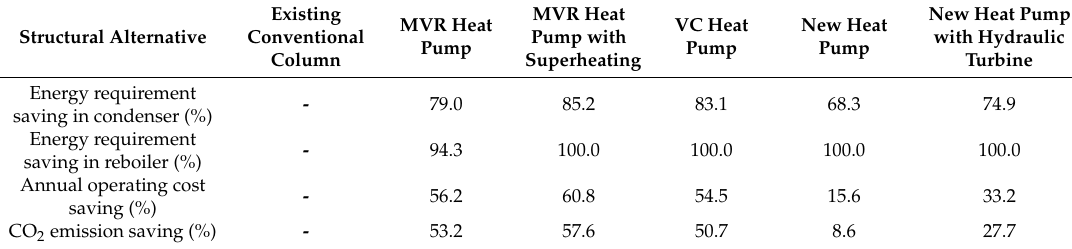
Table 2. Comparison of di ff erent structural